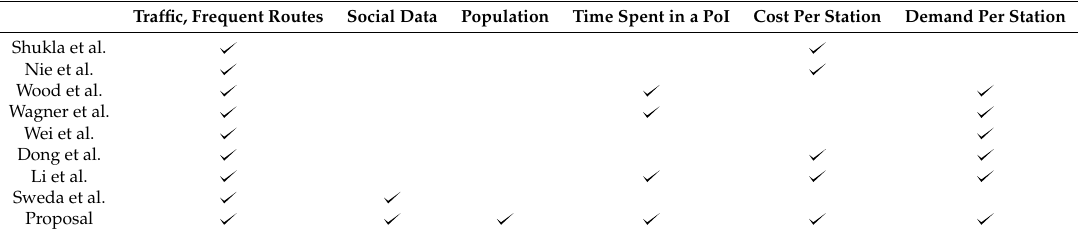
Table 1. Comparison of approaches that deal with the electric vehicle (EV) charging station placement. PoI: point of